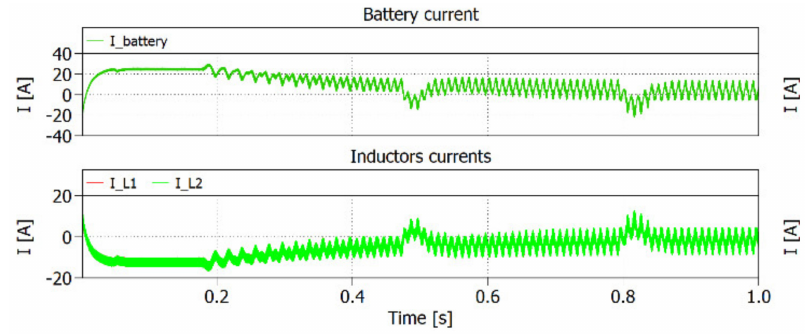
Figure 24. Battery and Bi-BB converter inductor currents for Scenario 2.